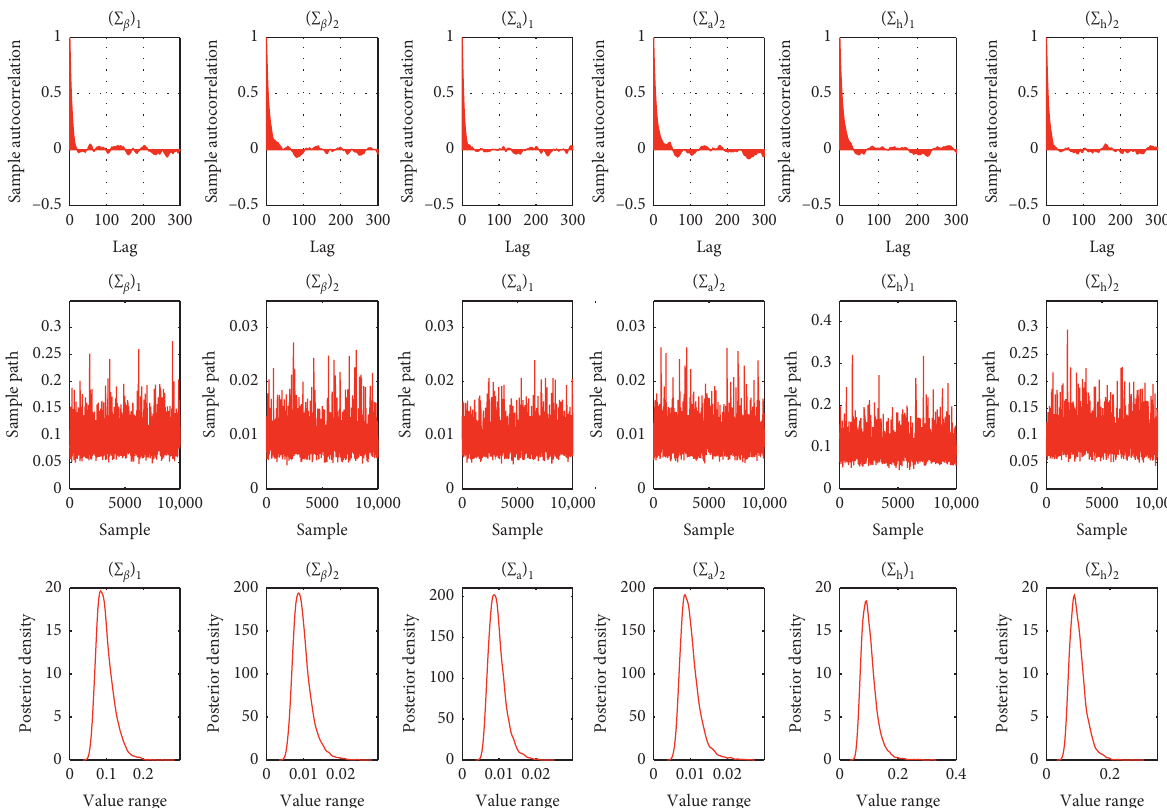
Figure 6: Sample autocorrelation function, sample path, and posterior density of TVP-SV-VAR